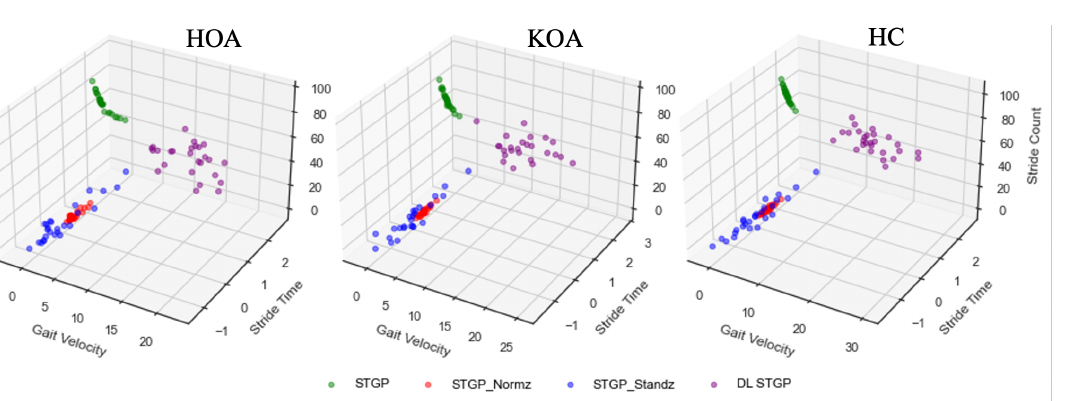
Figure 13. Examples of the three STGP features (gait velocity, stride time, and stride count) before and after applying data re-scaling for HOA, KOA, and HC. The green circles represent the raw STGP (before data re-scaling). The red, blue, and purple circles represent the normalized STGP, the standardized STGP, and the dimensionless STGP,